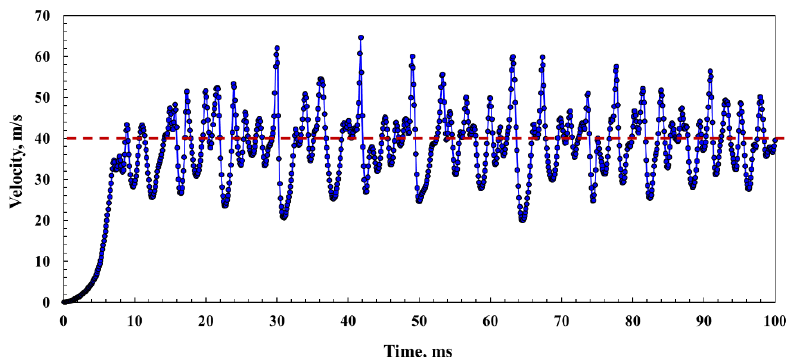
Figure 9. Change curve of axial velocity over time at the monitoring point.